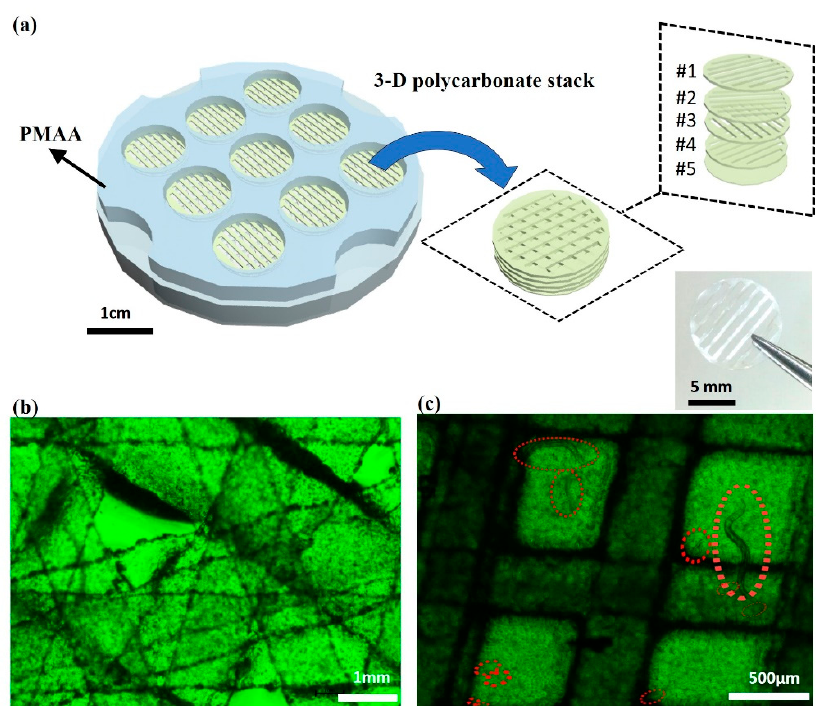
Figure 4. ( a ) Schematic diagrams of the 3-D culture system for C. elegans and microscopic images of the culture regions ( b ) without and ( c ) with C. elegans .